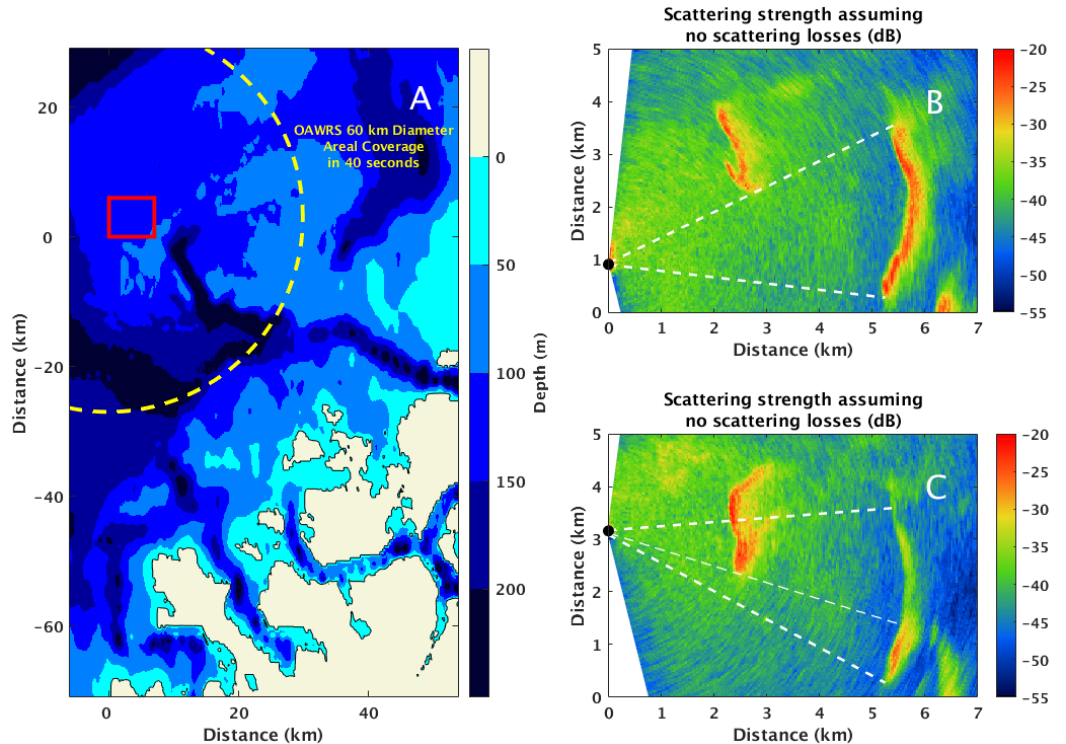
Figure 1. Attenuation from multiple forward scattering is observable in Ocean Acoustic Waveguide Remote Sensing (OAWRS) scattering strength images of herring in Ålesund waters. Variation in bathymetry near Ålesund is shown in ( A ). The yellow dashed circle shows 60-km diameter OAWRS areal coverage in 40 s. The red rectangular box represents the area investigated here. OAWRS scattering strength images assuming no scattering losses are shown from 21 February 2014 at 04:50:49 ( B ) and 04:33:19 ( C ). When the propagation path from the monostatic sensing system (black dot) to the distant shoal (Easting: 5–6 km, Northing: 0–4 km) has no occluding shoal, no attenuation is observable, as shown in ( B ). When an occluding shoal (Easting: 2–3 km, Northing: 2–4 km) is in the propagation path, the scattered returns from the same distant shoal are attenuated, as shown in ( C